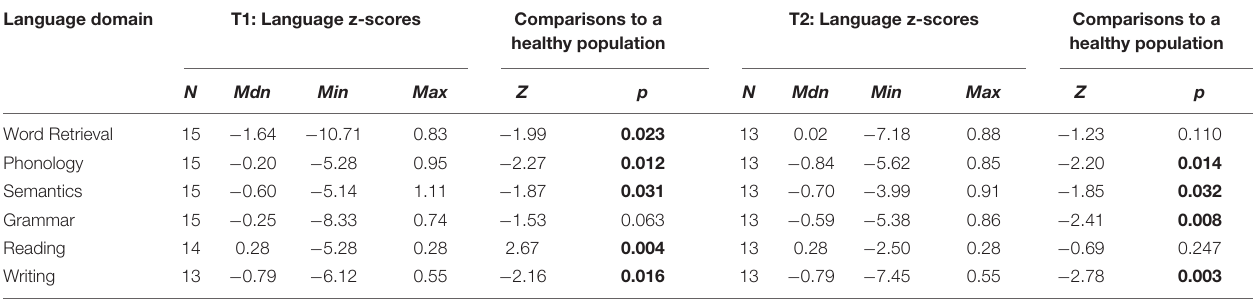
TABLE 4 | Language domain z-scores of glioma patients at T1 and T2, including comparisons to normative data from a healthy population. Language domain